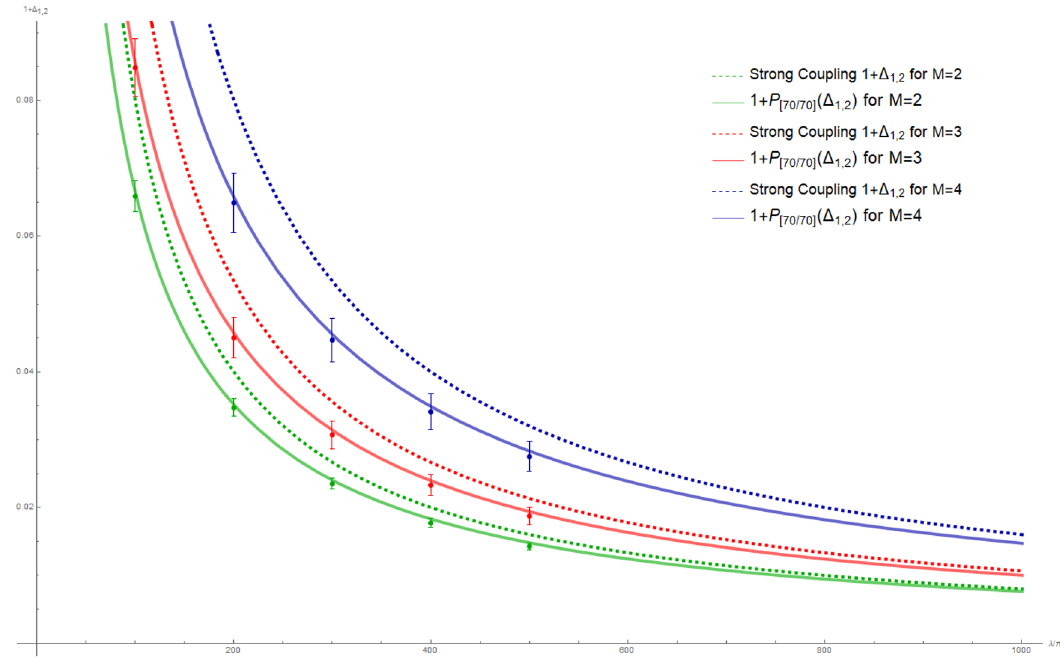
Figure 8 : Padé curves (solid lines), MC data (points with error bars) and the large- λ theoretical predictions for 1 + ∆ ( λ ) (dashed curves) in the range 100 π 2 ≤ λ ≤ 1000 π 2 1 , 2 for N = 50 and M = 2 (green), 3 (red) and 4